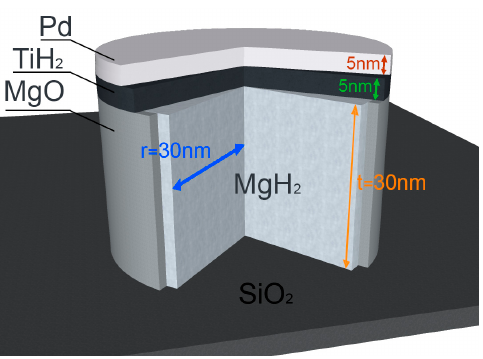
Figure 3. 3D Model for MgH 2 –TiH 2 nanodots (NDs); r = 30 nm is the radius and t = 30 nm is the thickness of MgH 2 . MgH 2 is covered with TiH 2 layer (5 nm) and a top Pd layer (5 nm).